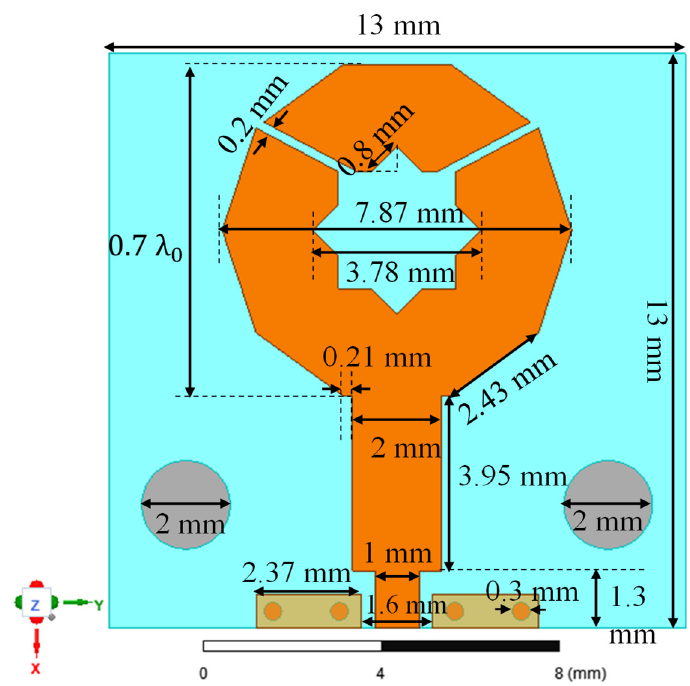
Figure 1. Proposed novel geometry and design parameters.